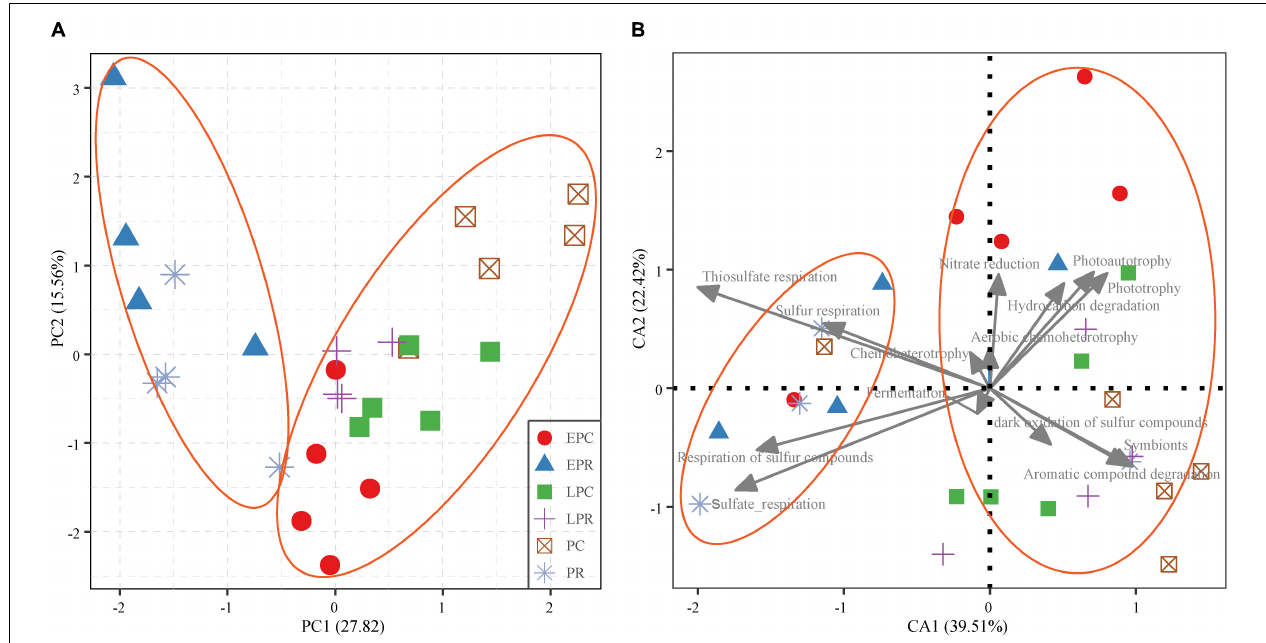
FIGURE 5 | The β -diversity of the bacterial community (A) and bacterial community function (B) . The shape and color of the point stand the different groups. The gray line is the dominant bacterial function (the relative abundance >